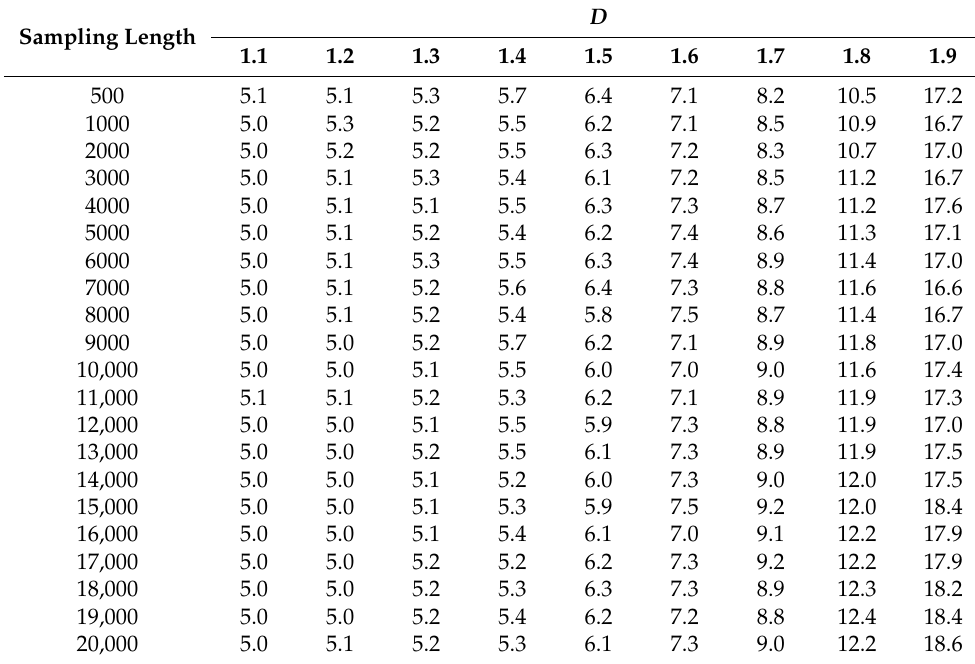
Table A6. Under all sampling lengths and all fractal dimensions, L d of drop points under the condition of 2-order flattening pre-processing.